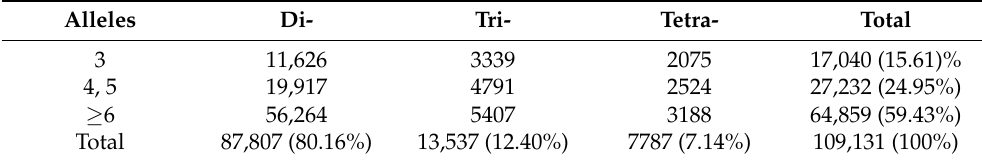
Table 1. Distribution of the number of alleles for each SSR type in the polymorphic SSR database. Alleles Di- Tri-